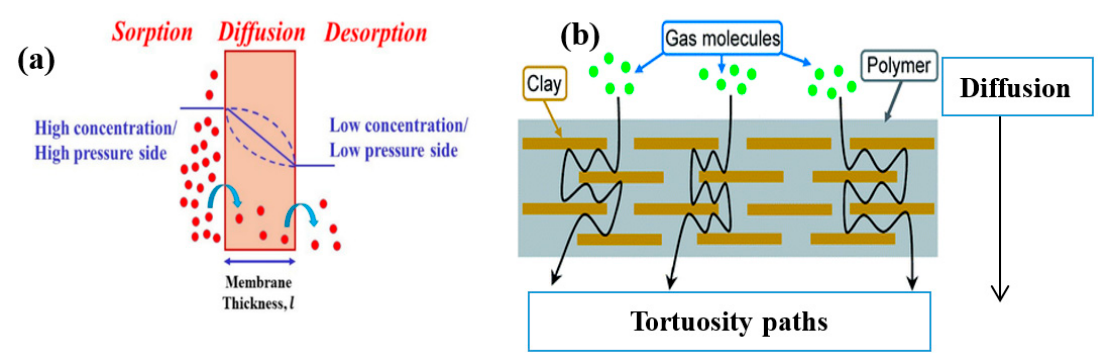
Figure 18. ( a ) Schematic illustration of the solution diffusion model. Reproduced with permission from Reference [168]. Open Access 2020, MDPI Polymers. ( b ) Schematic illustration of the tortuous path model. Reproduced with permission from Reference [95]. Open Access 2017, RSC Advances.